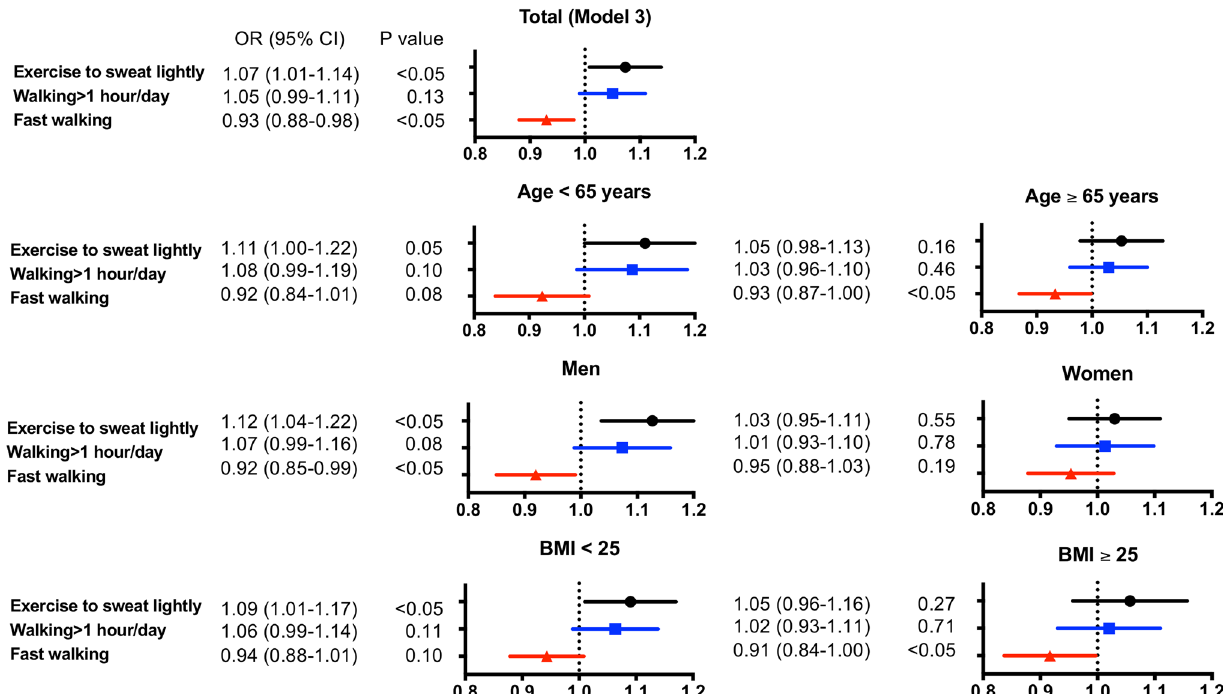
Figure 1. Adjusted odds ratio (OR) for new-onset diabetes mellitus (model 3). Among non-diabetic participants aged 40–74 years (n = 167,684), adjusted ORs (95% confidential intervals) for new-onset diabetes mellitus in the 3-year follow-up were calculated for exercise to sweat lightly ( fast walking ( ▲ ). Model 3: adjusted for sex, age, body mass index (BMI), systolic blood pressure (SBP), current smoking, drinking, weight gain over 10 kg from 20 years of age, weight change of 3 kg within 1 year, exercise to sweat lightly, walking > 1 h/day and fast